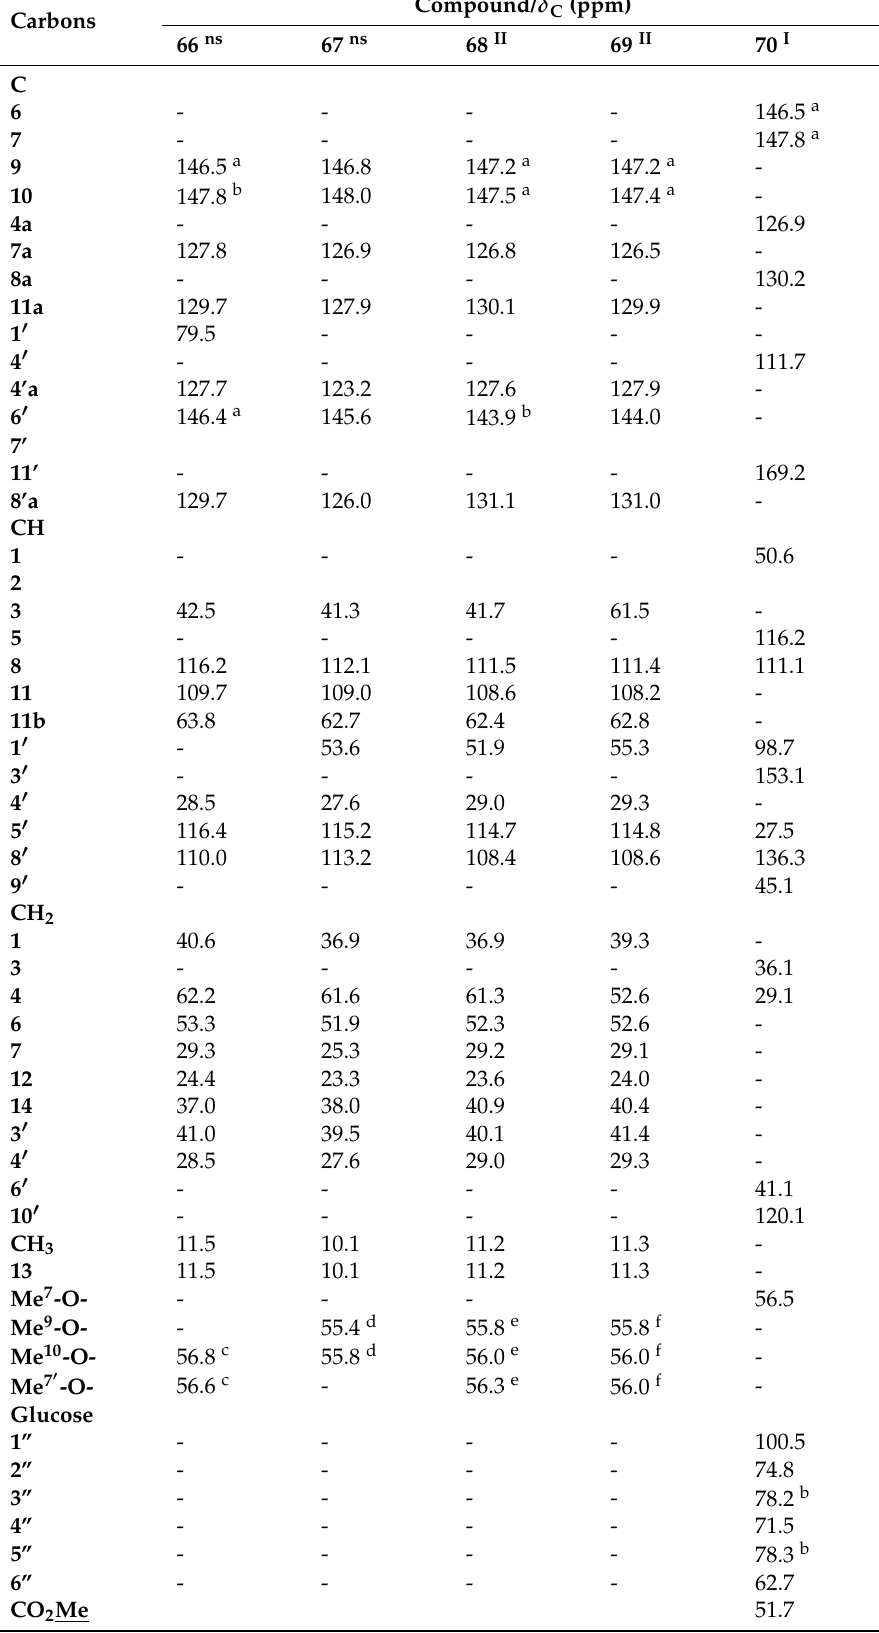
Table 6. 13 C-NMR Data of Benzoquinolizidine Alkaloids from P. klugii